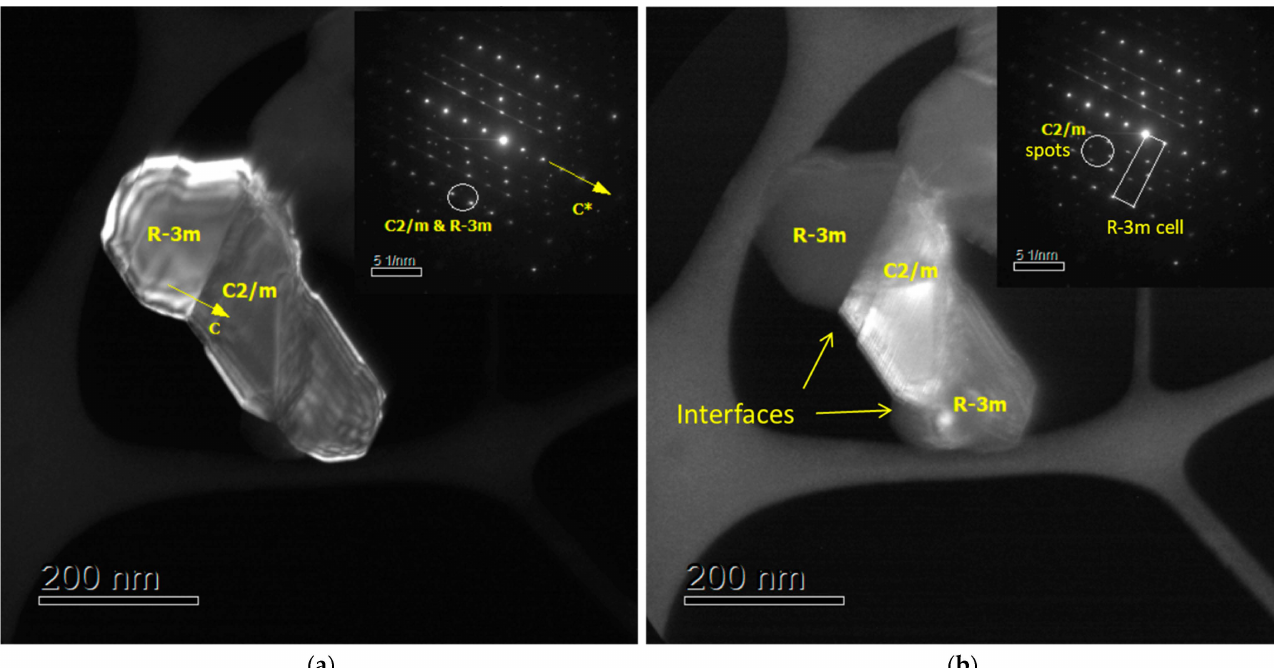
Figure 2. Results of TEM study of the reference sample Li 1.2 Mn 0.54 Ni 0.13 Co 0.13 O 2 (LR): ( a , b ) DF images of a grain with intergrowth of crystals taken with the reflections marked with circles in SAED patterns; SAED patterns along the (100) m zone are shown in the